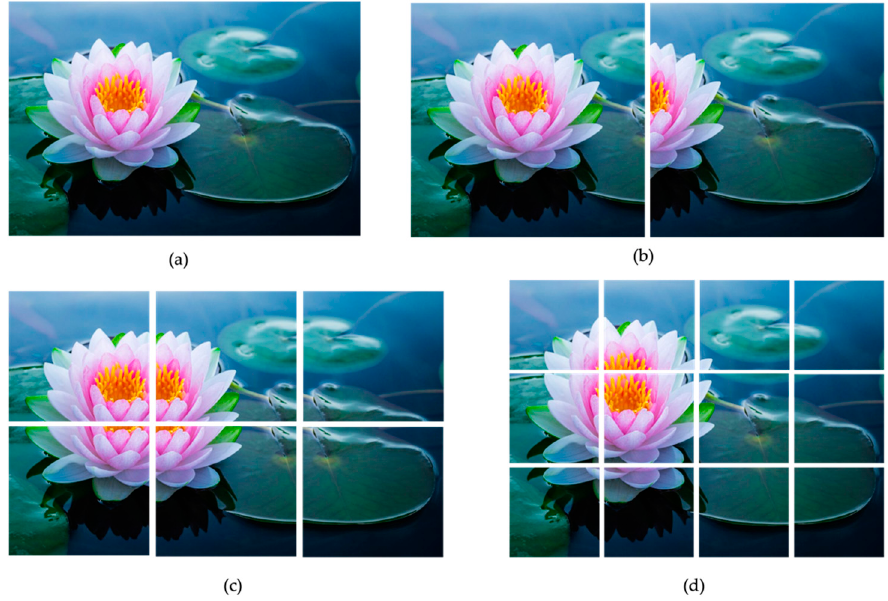
Figure 3. Example of RMAC regions. ( a ) Query image, ( b ) Two first areas of RMAC method, ( c ) Six next areas of RMAC method, ( d ) Twelve last areas of RMAC